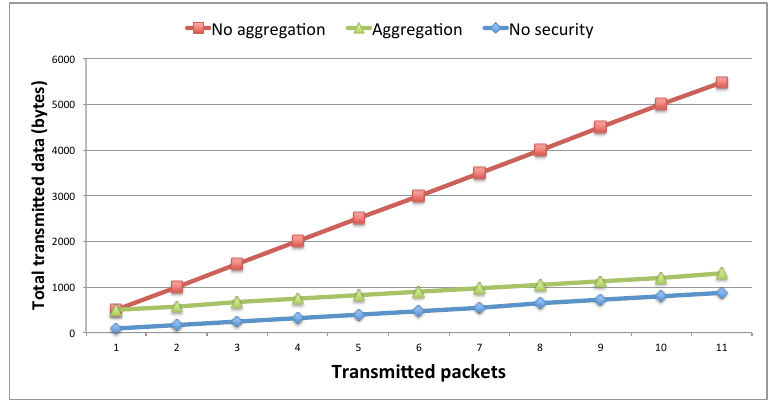
Figure 6. Total transmitted data for using and not using the aggregation